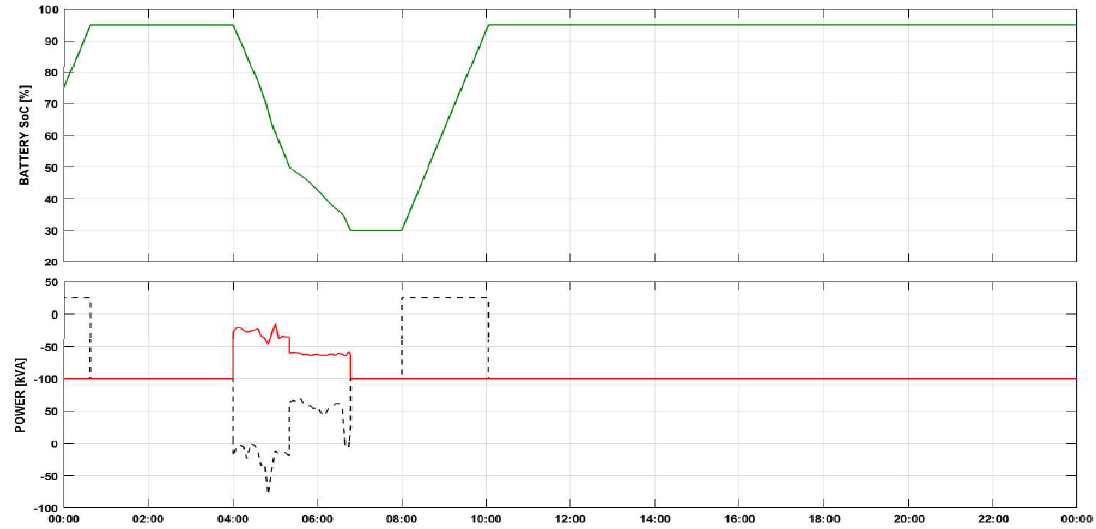
Figure 18. The behavior of MCAST micro-grid integrated with a 150 kWh BESS and 150 kVA diesel generator during a 4- h power cut.